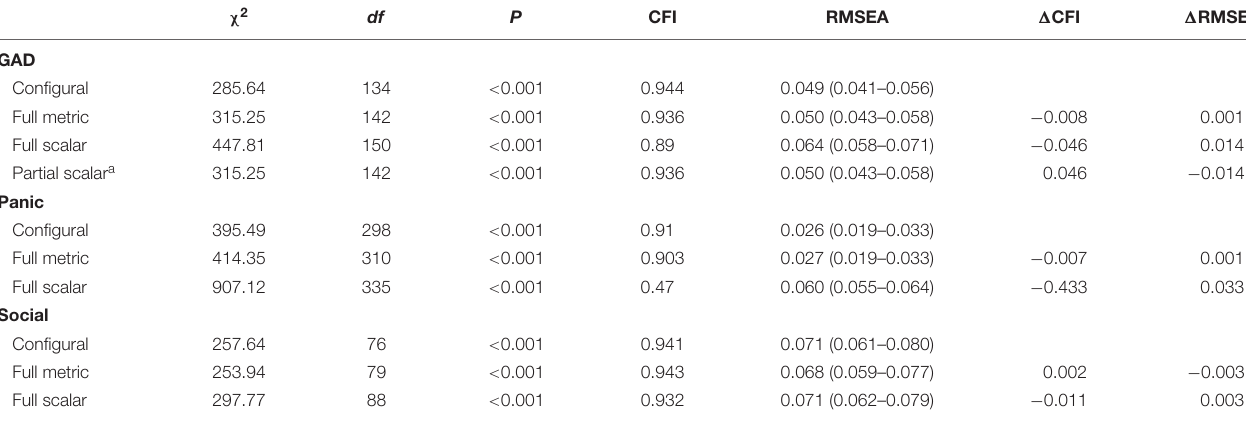
TABLE 3 | Tests of MI between child self- and maternal-reports at age 12.